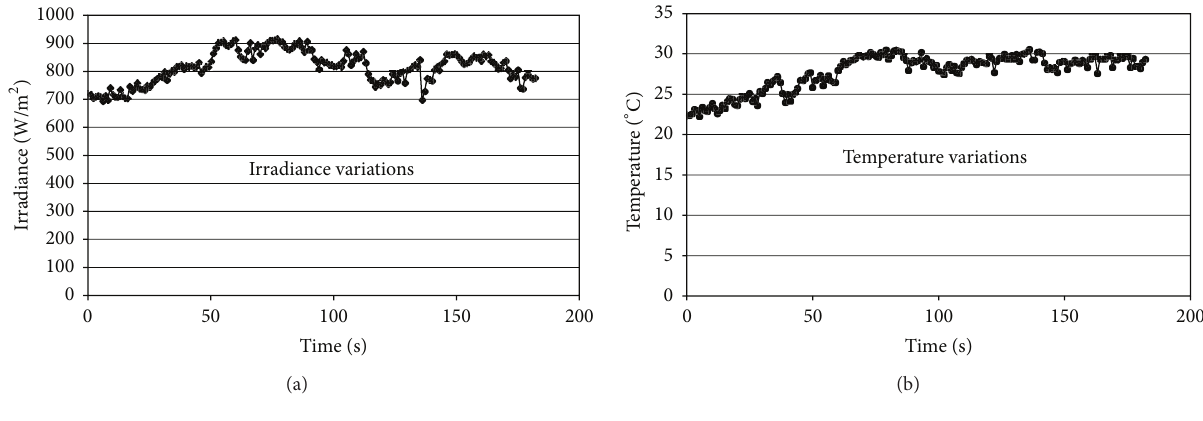
Figure 10: Solar irradiance and temperature variations.